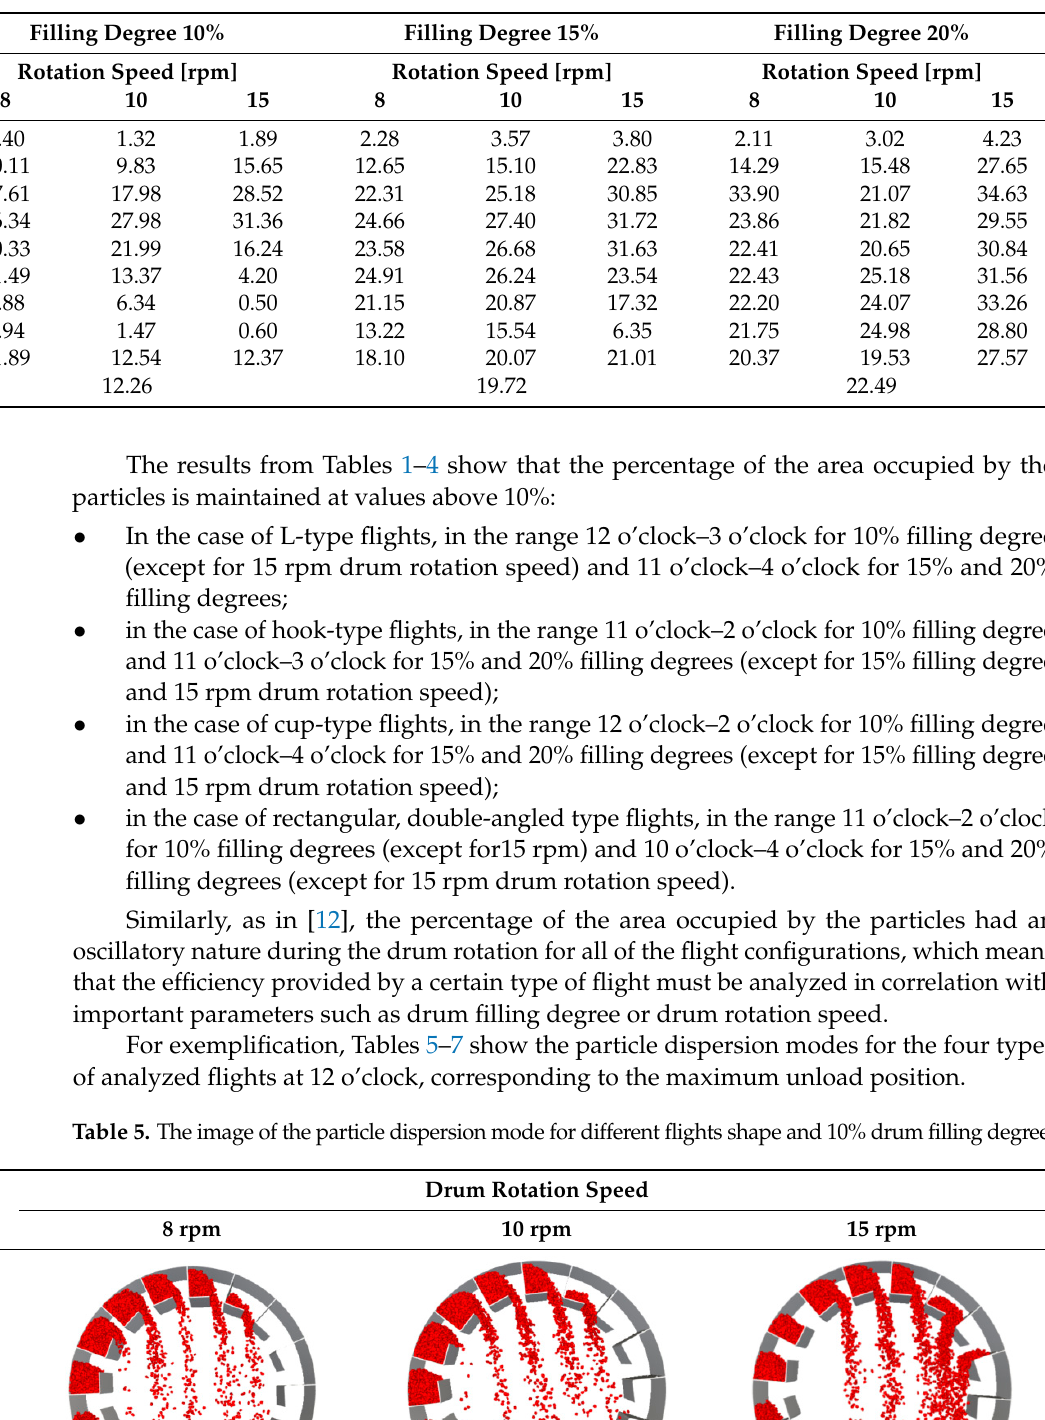
Table 4. The values of the percentage of the area occupied by the particles ( AOR %) for rectangular, double-angled type flights.